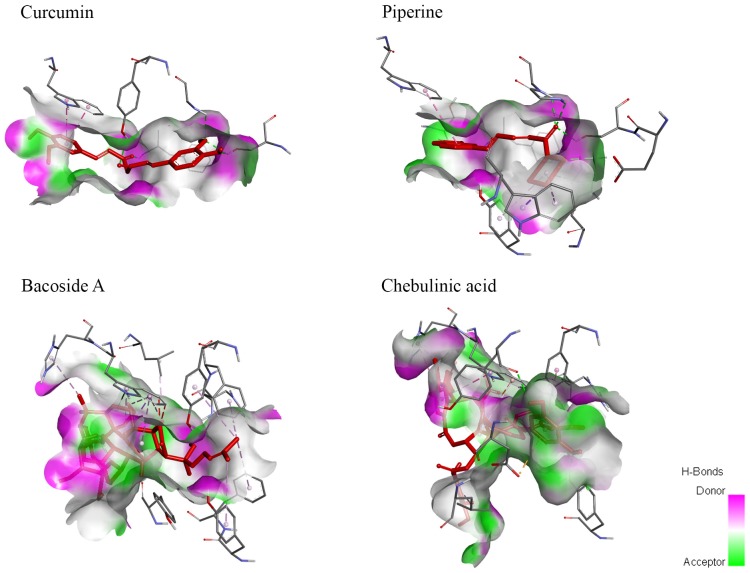
Hydrogen bond molecular surface mapped the locations of hydrogen bonds in ligands when bound to AChE. Curcumin and piperine demonstrated a high number of hydrogen bond donors and hydrogen bond acceptors. Meanwhile, bacoside A showed a higher number of hydrogen bond donors while chebulinic acid presented with a higher number of hydrogen bond acceptors.